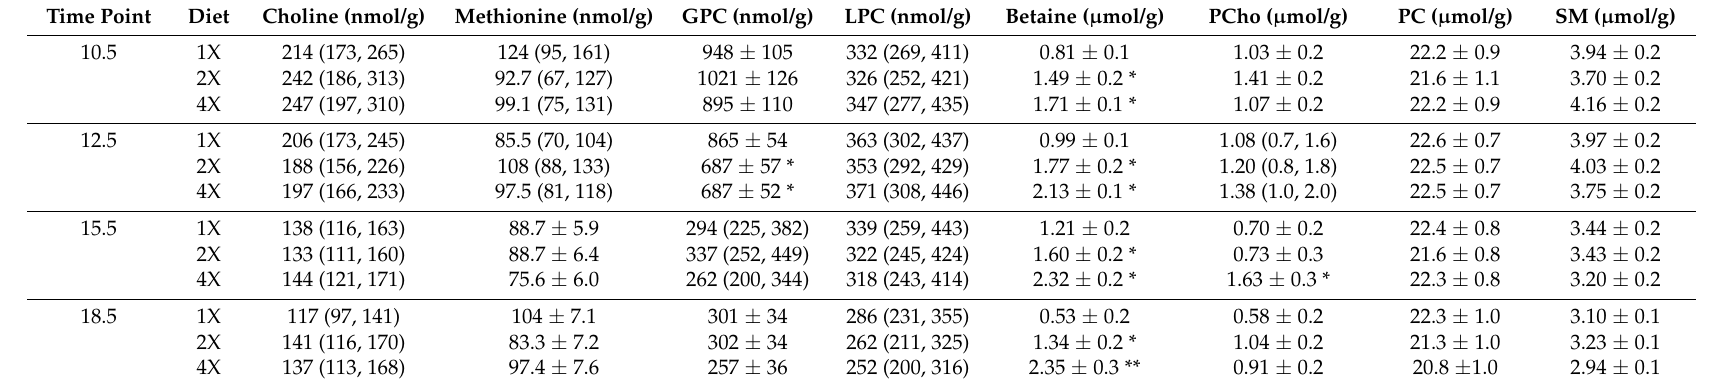
Table 1. Maternal liver concentrations of choline metabolites (per gram tissue) at E10.5, E12.5, E15.5, and E18.5 by choline treatment. Data were analyzed using general linear models with treatment and litter size as fixed factors. Values are presented as mean ± SEM. Log-transformed variables are represented by back-transformed means and 95% confidence intervals (in parentheses). * Significantly different versus control diet, p ≤ 0.05. ** Significantly different versus 1X and 2X diets, p ≤ 0.05. GPC, glycerophosphocholine; GPC, phosphatidylcholine; PCho, phosphocholine; LPC, lysophosphatidylcholine; SM, sphingomyelin. n = seven to 10 dams per treatment, per time